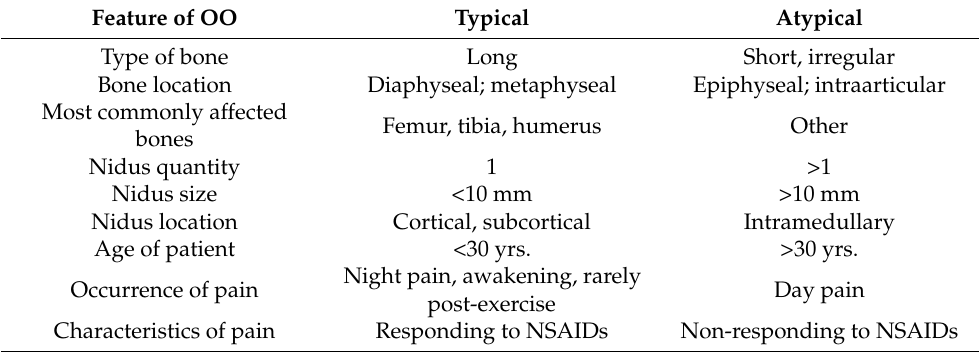
Table 1. Comparison of typical and atypical features of osteoid osteoma [25–28]. Feature of OO Typical